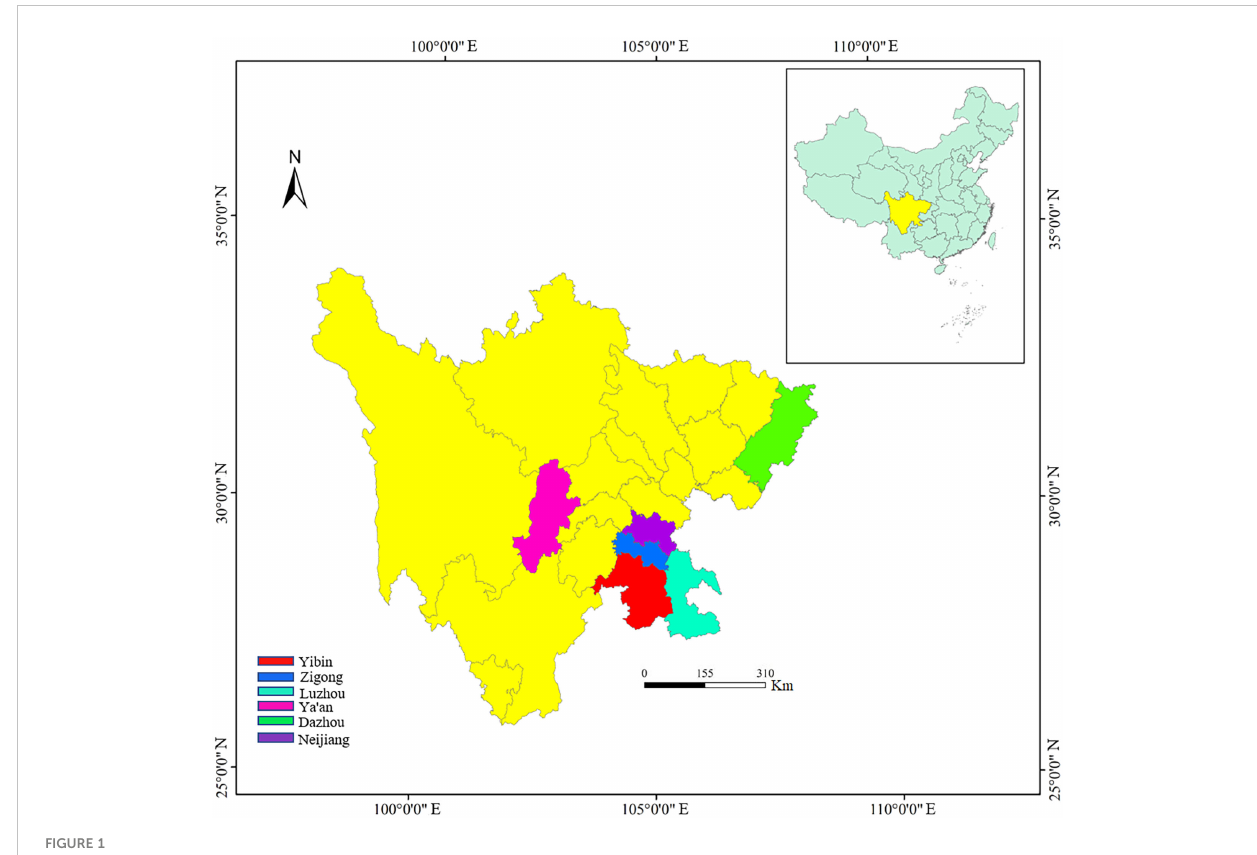
FIGURE 1 The city distributing the collection of wild C. oleifera germplasm